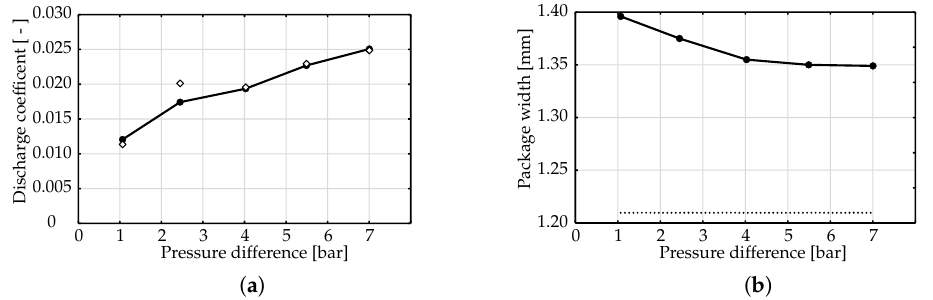
Figure 4. ( a ): Discharge coefficients from experiment ( ) and numerical simulation (CFD) ( ) under variation of the pressure difference; ( b ): Package width depending on the pressure difference ( ), B min (